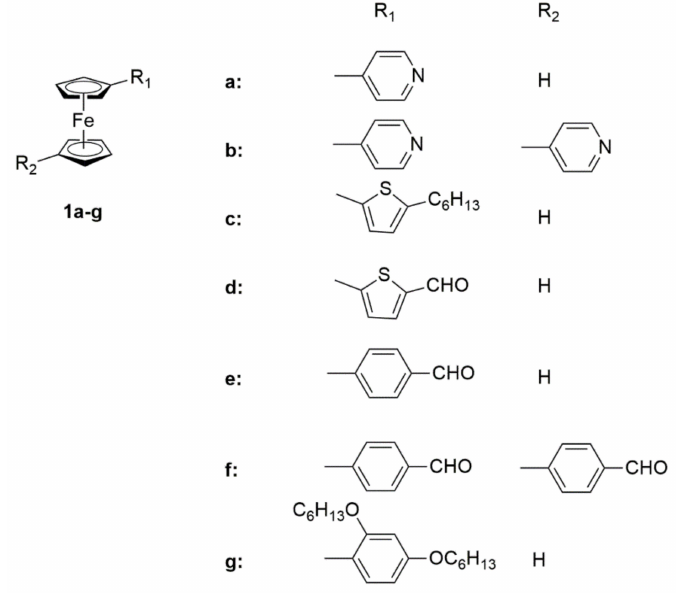
Figure 1. Mono- and bis-substituted Fc derivatives ( 1a–g